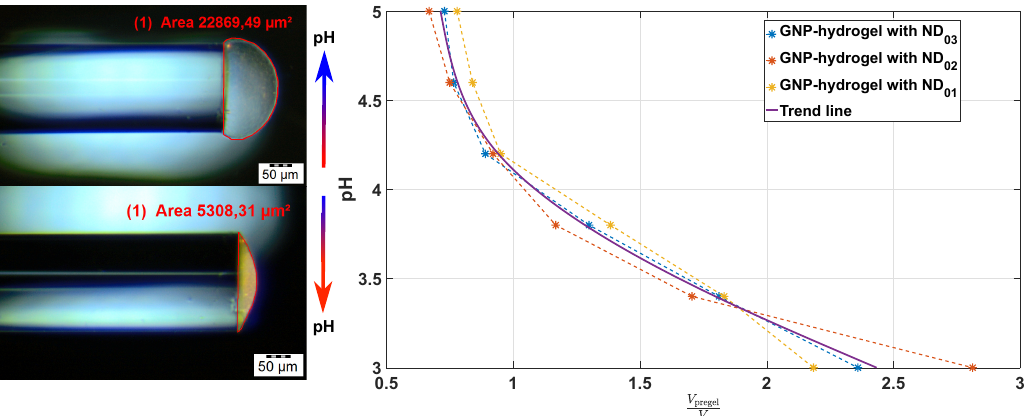
Figure 5. Estimate of the hydrogel volume for the decrease in pH from 5 to 3 based on observations in an optical microscope. The uncertainties of the volume measurements are estimated to be within 1 and 5%. ND, number